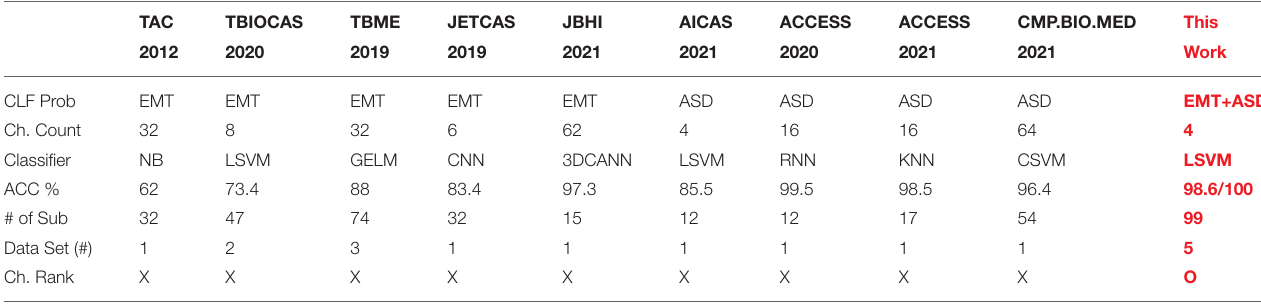
TABLE 2 | Comparison with the related